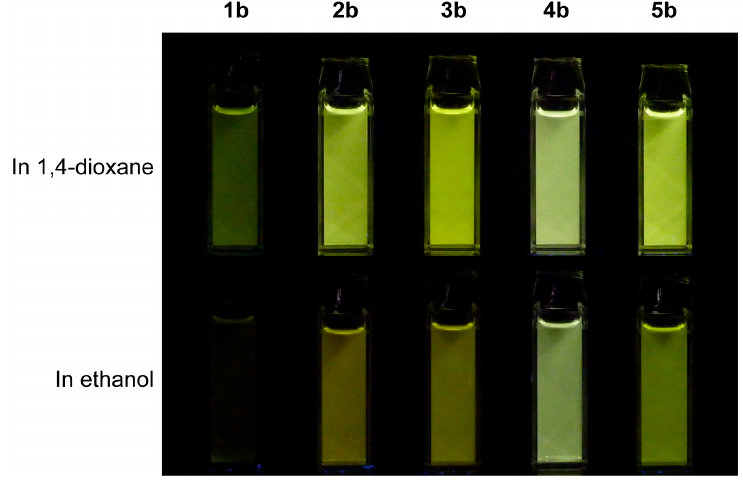
Figure 3. Photographs of fluorescent emissions of closed-ring isomers 1b – 5b in 1,4-dioxane and ethanol.